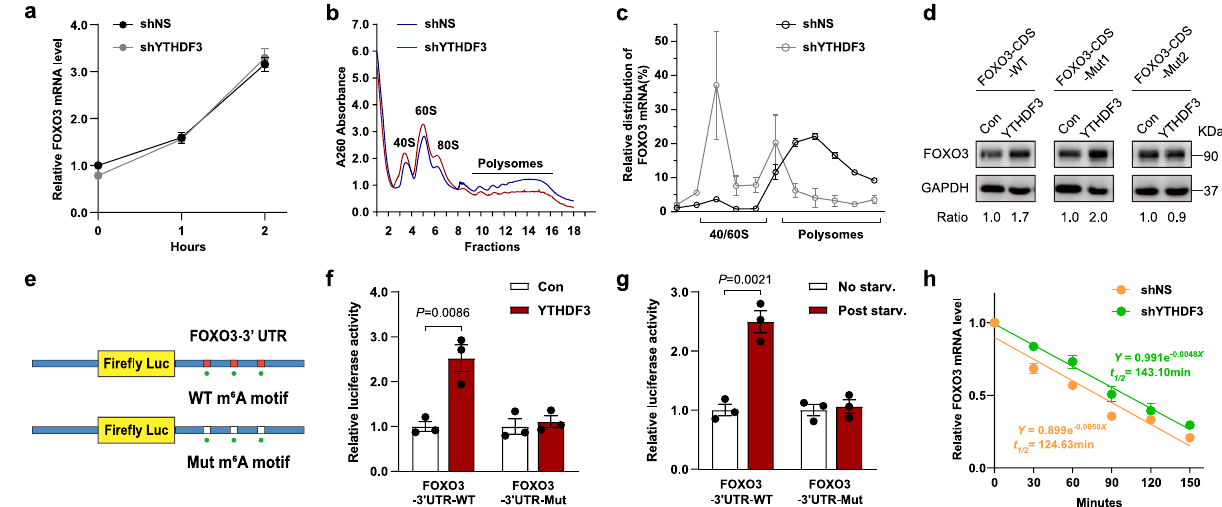
Fig. 7 | YTHDF3 promotes FOXO3 translation but does not affect its mRNA stability. a qRT-PCR analysis of FOXO3 in shNS and shYTHDF3 MEFs following nutrient starvation for the indicated time periods. b Sucrose gradient-based poly- some pro fi ling of shNS and shYTHDF3 MEFs. c FOXO3 mRNAs in each ribosome fraction were quanti fi ed through qRT-PCR and plotted as percentages of the total. d Lv-FOXO3-CDS-WT, Lv-FOXO3-CDS-Mut1, or Lv-FOXO3-CDS-Mut2 were trans- fected into control and YTHDF3-OE MEFs. Protein expression was measured by western blot analysis and then quantitatively analyzed. e Schematic diagram of wild-type or mutant m 6 A sites (A-to-T mutation) in the FOXO3-3 ’ UTR, fused with a